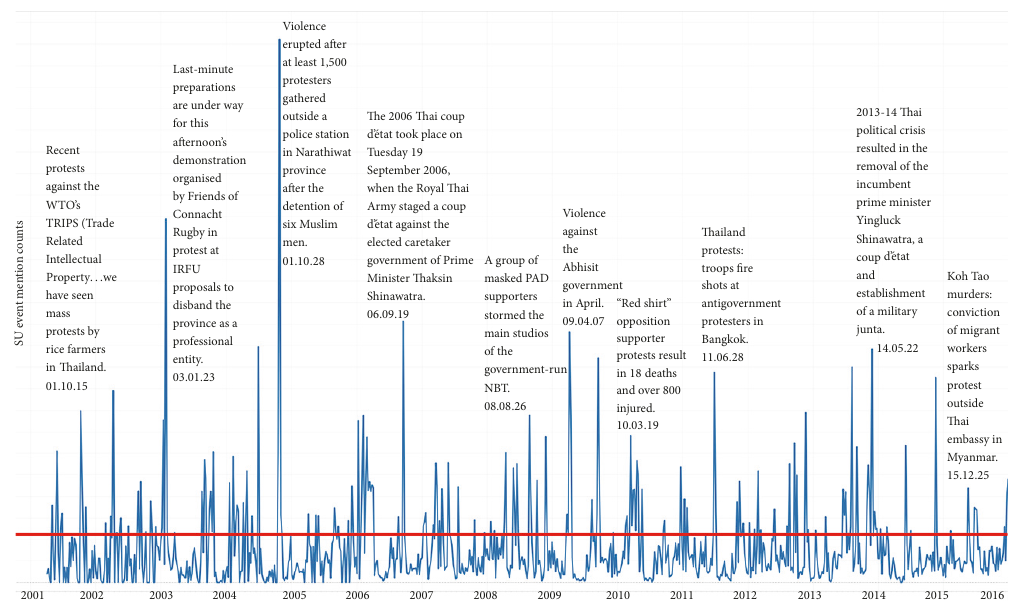
Figure 5: Normalized SU event mention counts of Thailand with annotations for top ten stretches above 𝜃 (red line).